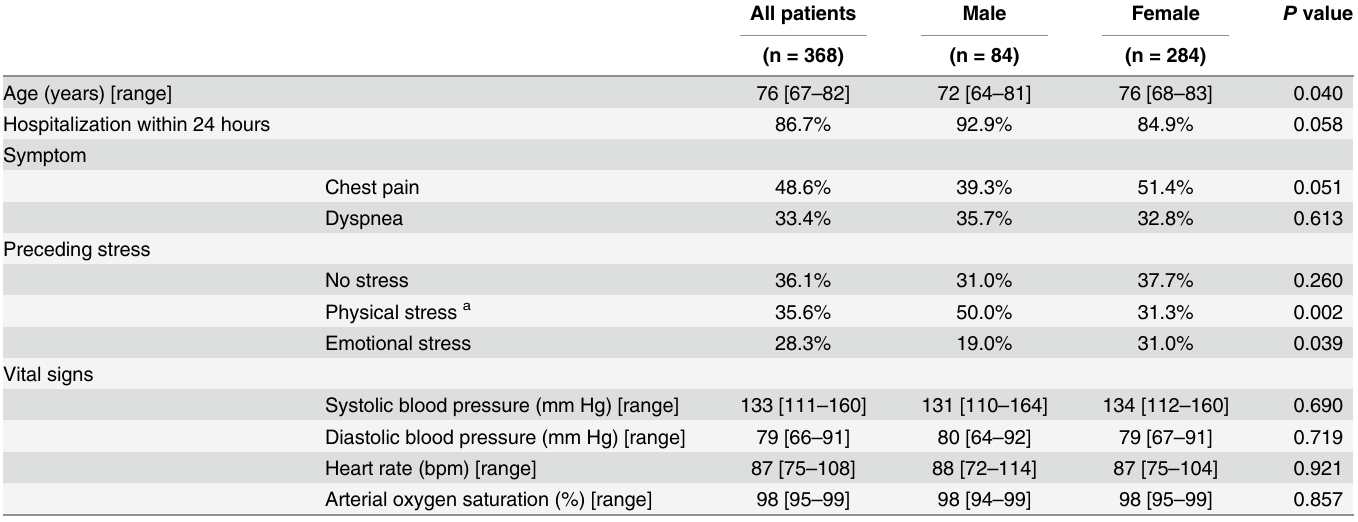
Table 1. Patient